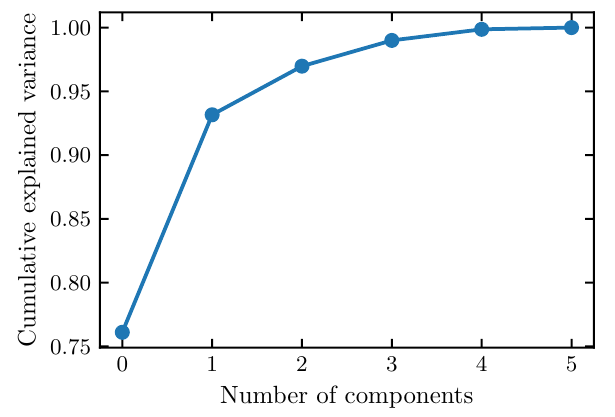
Figure A2. The cumulative sum of the explained variance of the principal